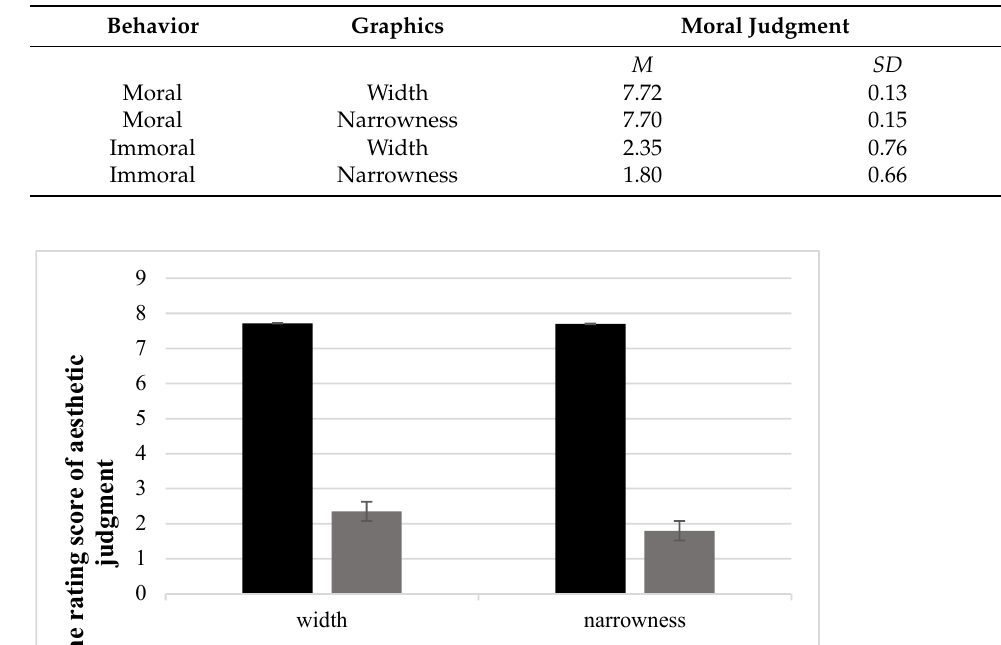
Table 4. Mean rating of moral judgment under different conditions (M ± SD).